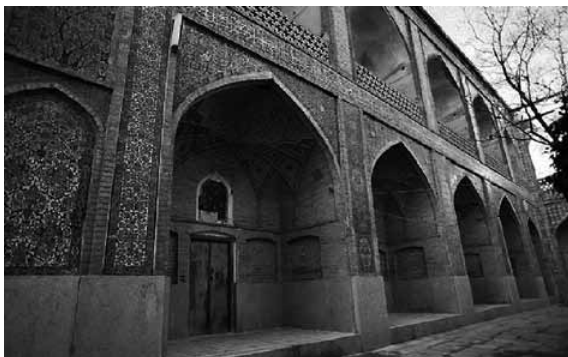
fig. 17. Khan School dorms in the forms of small private rooms (photo by the